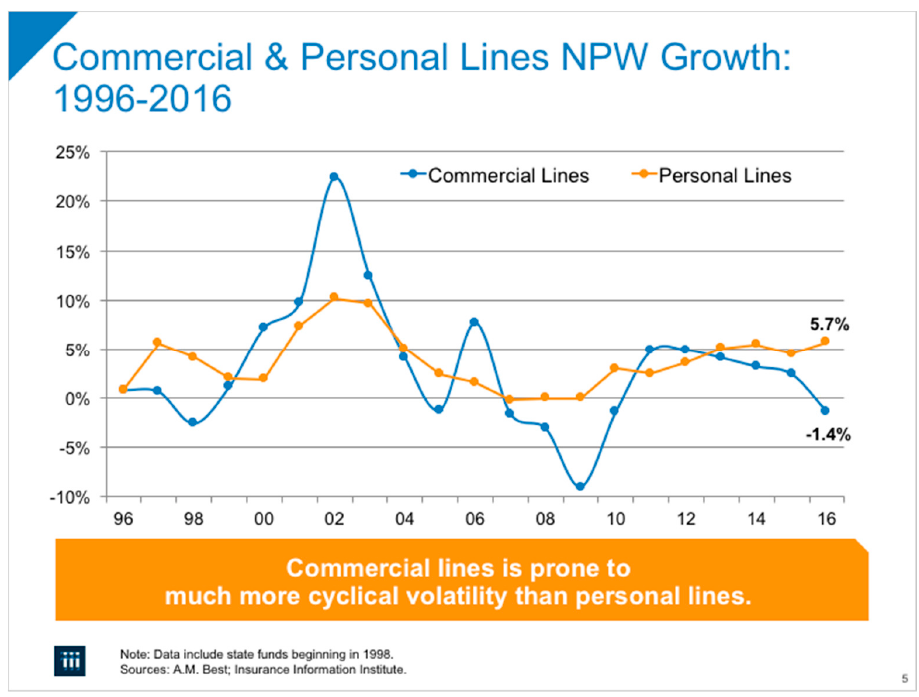
Figure 2. Commercial & Personal Lines NPW Growth: 1996–2016.